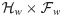
Model-Data comparison of simulated and observations-based GPP over the European continent.Colour-coded Hw×Fw (bottom right), as obtained from (top left) MTE-MR, (bottom left) JSBACH, and (bottom right) LPJmL. The causal information planes illustrating the point densities are given in the insets.